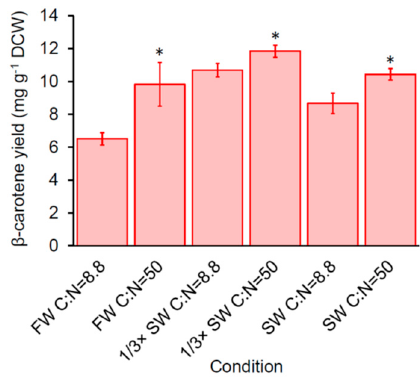
Figure 3. Effect of carbon-to-nitrogen ratio (C:N) on β -carotene production of SM14 after 72 h. FW: fresh water; SW: seawater.. Error bars are standard deviations. *: Statistically significantly different between condition A and B of the same water sources (* p -value < 0.05).